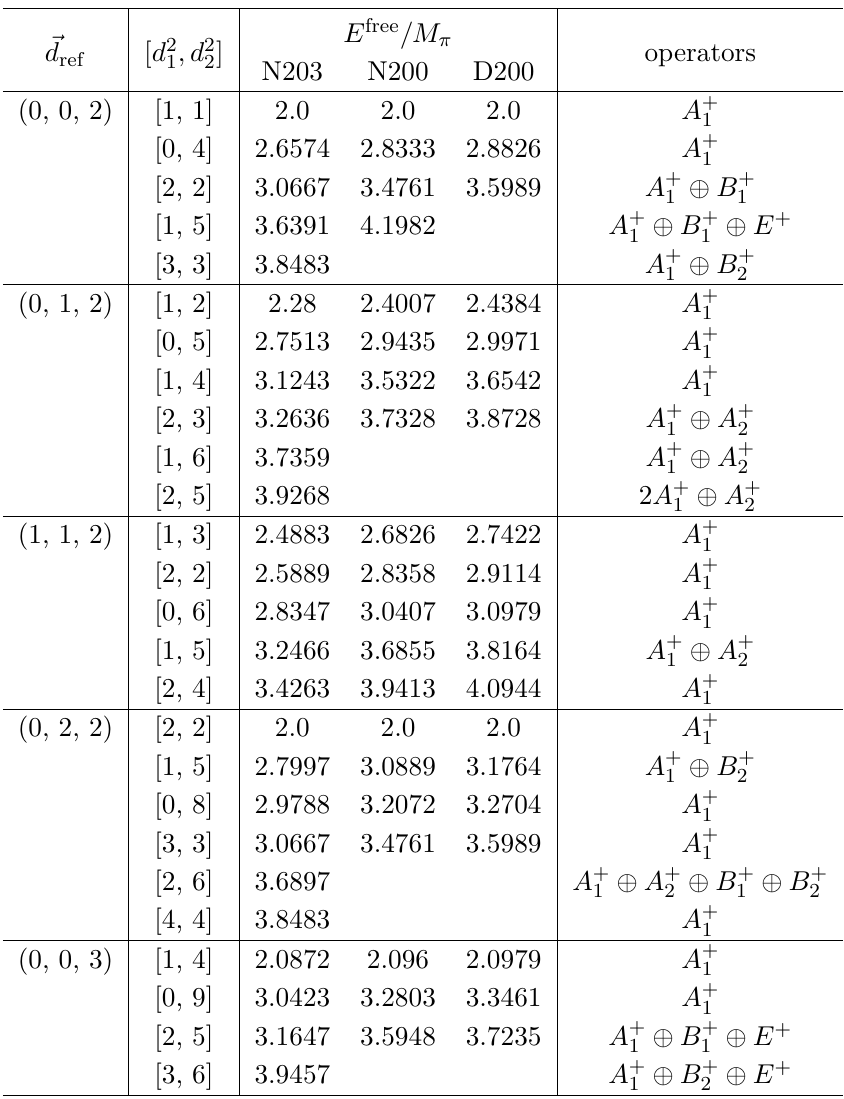
Table 28. Same as table 21 except for the two-pion operators with 4 ≤ ~d 2